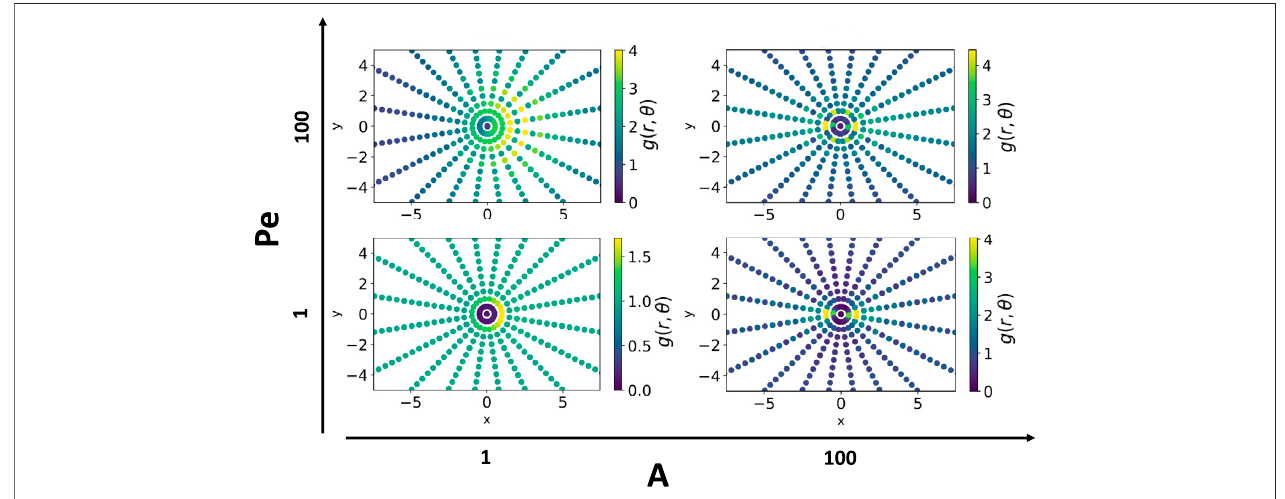
FIGURE 5 | Angular dependent pair correlation function is affected by both motility and elastic interactions. Strong elastic interactions promote pair correlation peaks at ( r , θ ) = ( σ , 0), ( σ , π ). At Pe = 1, these are the only prominent peaks in the pair correlation function. Motile activity gives rise to secondary peaks at roughly ( r , θ ) = ( σ , π mod π ), ( σ , 2 π mod π ) as the preeminent structures are bundles of offset traveling chains. Weak elastic interactions broaden the pair correlation distribution. In this 3 3 case, motility breaks head-tail symmetry and peaks can be seen at multiple integers of particle diameter at the head ( θ = 0